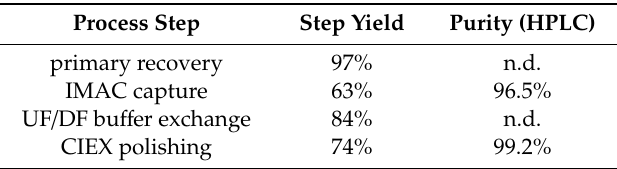
Figure 5. Summary of all engineering and fermentation development steps for the efficient production of soluble of cp caspase-2. Table 1. Step yields of the T7AC-cpCasp2